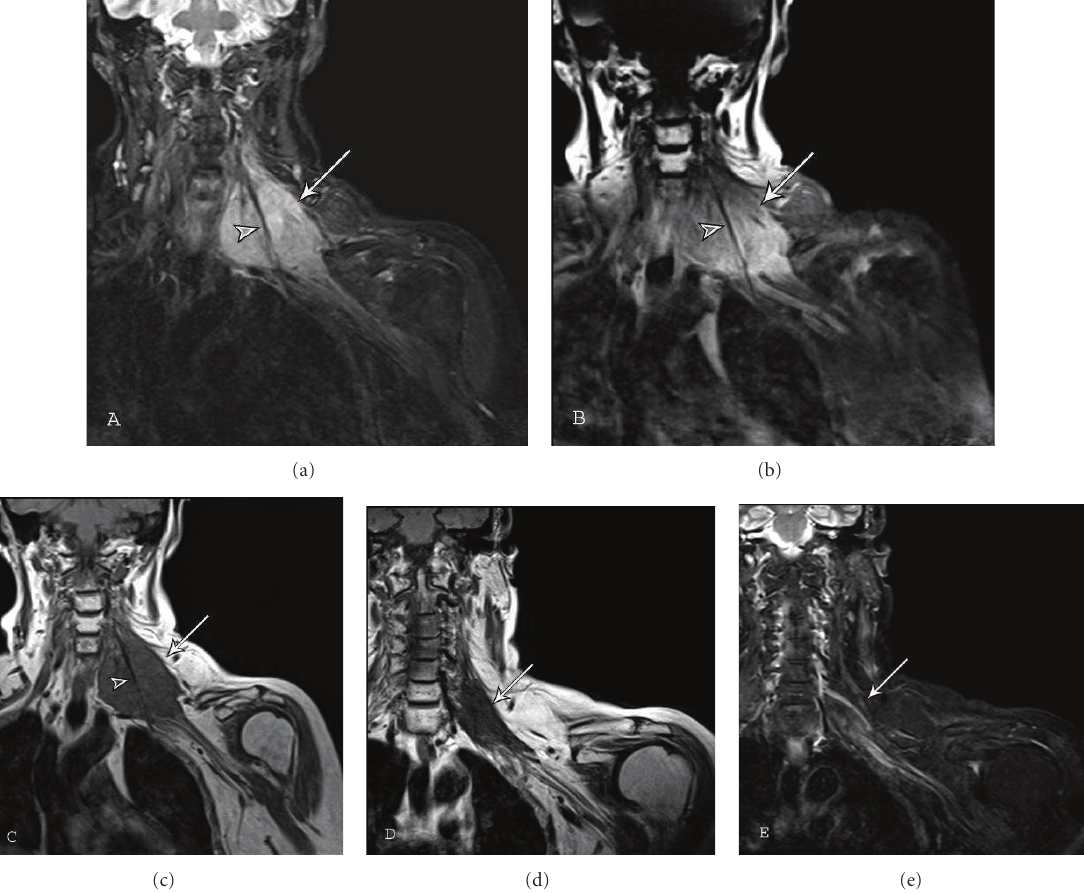
Figure 5: Extraabdominal fibromatosis of the left brachial plexus: a 64-year-old female presented with left shoulder and upper arm pain. The lesion was not amenable to surgical resection because of the intimate relationship with neurovascular structures of the left brachial plexus. (a) Coronal T2-weighted (TR4130/TE30) fat saturation and (b) coronal T1-weighted (TR576/TE11) postcontrast fat suppression sequences reveal a heterogeneous intermediate-to-high signal lesion with moderate and di ff use enhancement (arrows). Note the low-intensity band (arrowheads) corresponding to an acellular, collagen rich area interspersed between the highly vascularized fascicles of spindle cells. (c) Coronal T1-weighted (TR560/TE11) image obtained at presentation is compared to (d) coronal T1-weighted (TR572/TE14) and (e) STIR (TR5560/TE34) images obtained two years and four months after the previous images and status after completing radiotherapy (50.4 gray in 28 fractions). The lesion (arrows) reveals decrease in size and lower T1 and STIR signal indicating mature collagenized tissue after treatment.